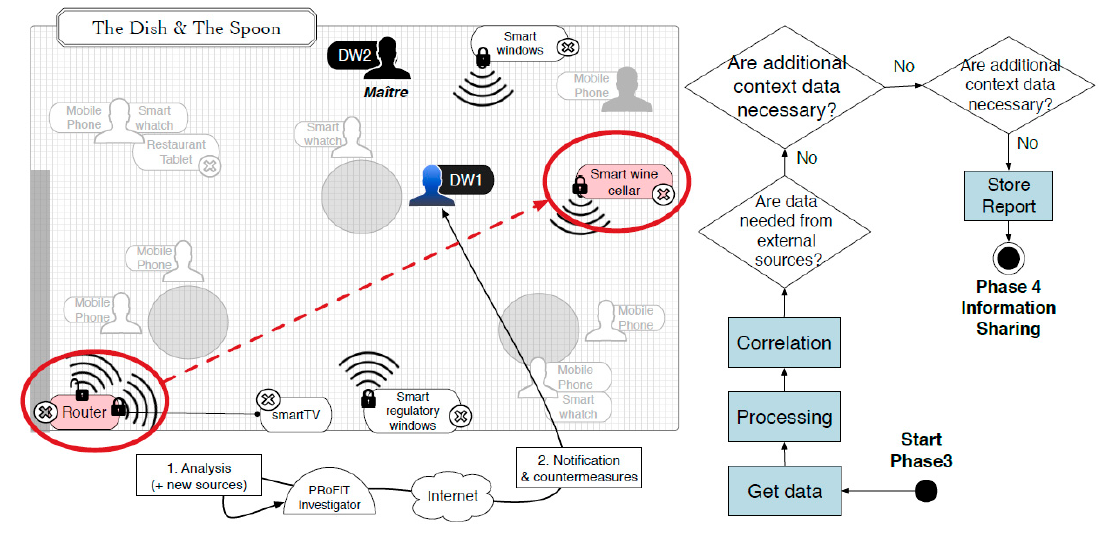
Figure 9. Conclusions of the investigation in the